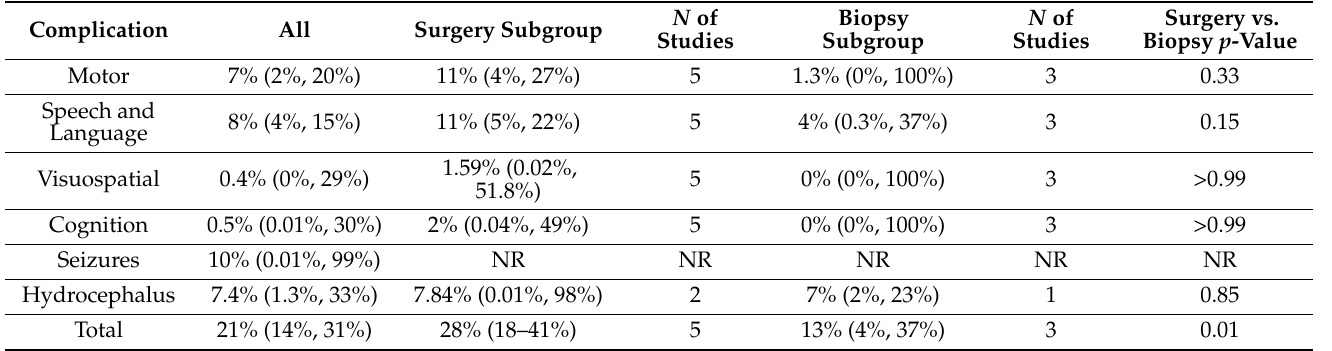
Table 4. Pooled incidence of complications (95% confidence intervals) † comparing surgery to bi- opsy.